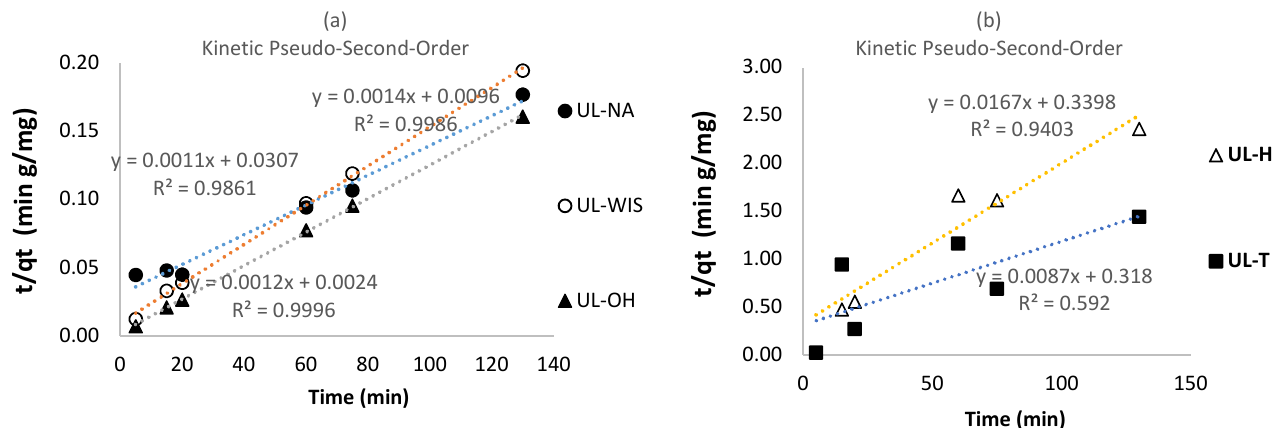
Figure 11. Kinetic pseudo-second-order of MB adsorbed by dry U. lactuca biomass: UL-NA, UL-WIS, and UL-OH ( a ), UL-H and UL-T ( b ). Experimental conditions: 5g L −1 adsorbent concentration, pH = 8, T = 25 °C, C0 (MB) = 5 × 10 −5 mol/L.